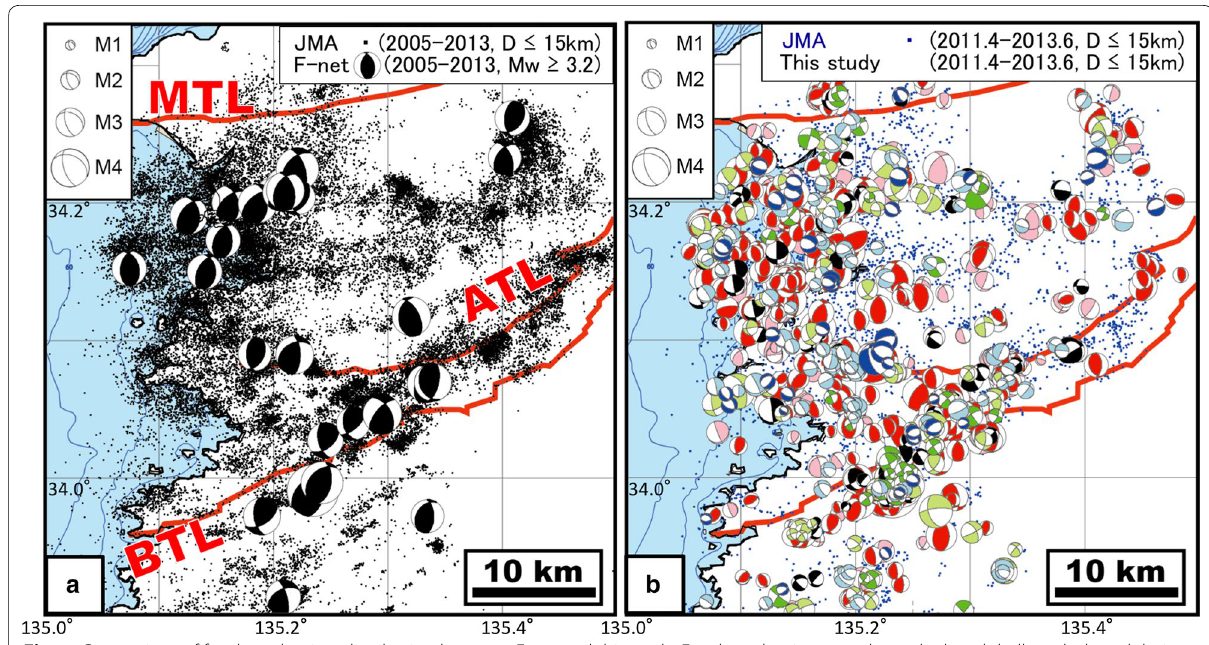
Fig. 5 Comparison of focal mechanism distribution between F-net and this study. Focal mechanisms are shown by beach ball symbols and their sizes are proportional to their magnitudes. Epicenter distributions are from the JMA catalog and shown by dots. a F-net (NIED) focal mechanism solutions (Mw 3.2) and epicenter distribution. Period shown is 2005–2013. E–W compressional reverse-faulting events are dominant in this ≥ region. b Focal mechanisms determined in this study and epicenter distribution. Period shown is April 2011 to June 2013. Focal mechanisms are colored according to the classification shown in Fig. 3. We successfully determined 854 reliable focal mechanism